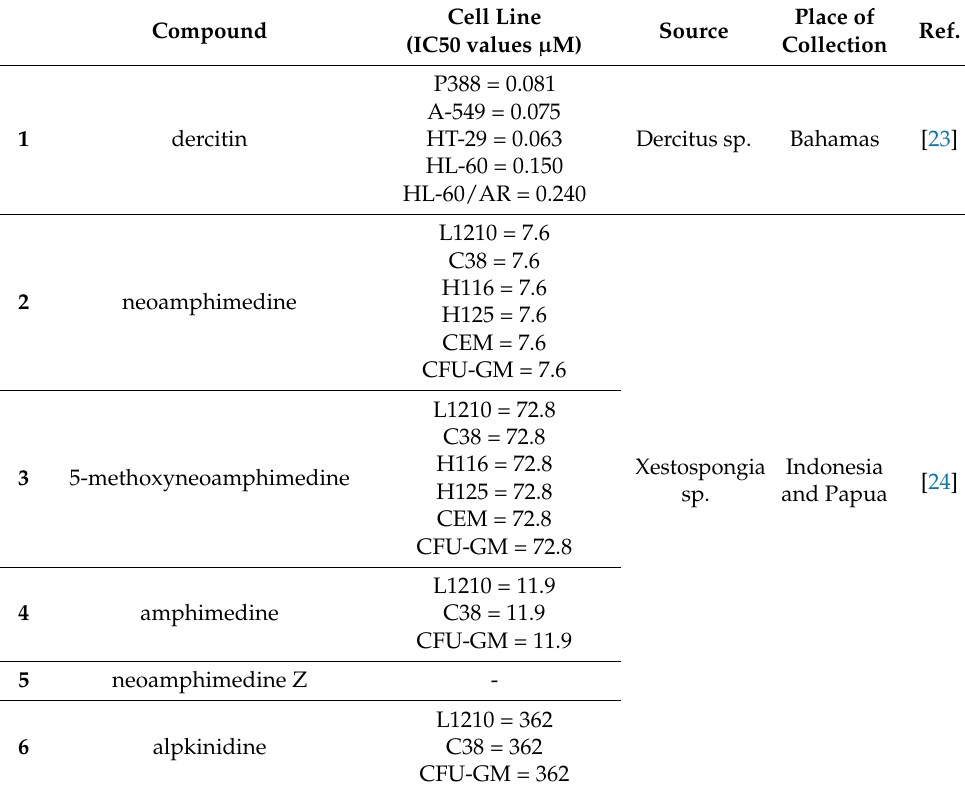
Figure 2. Structures of β -carboline alkaloids isolated from sponges.